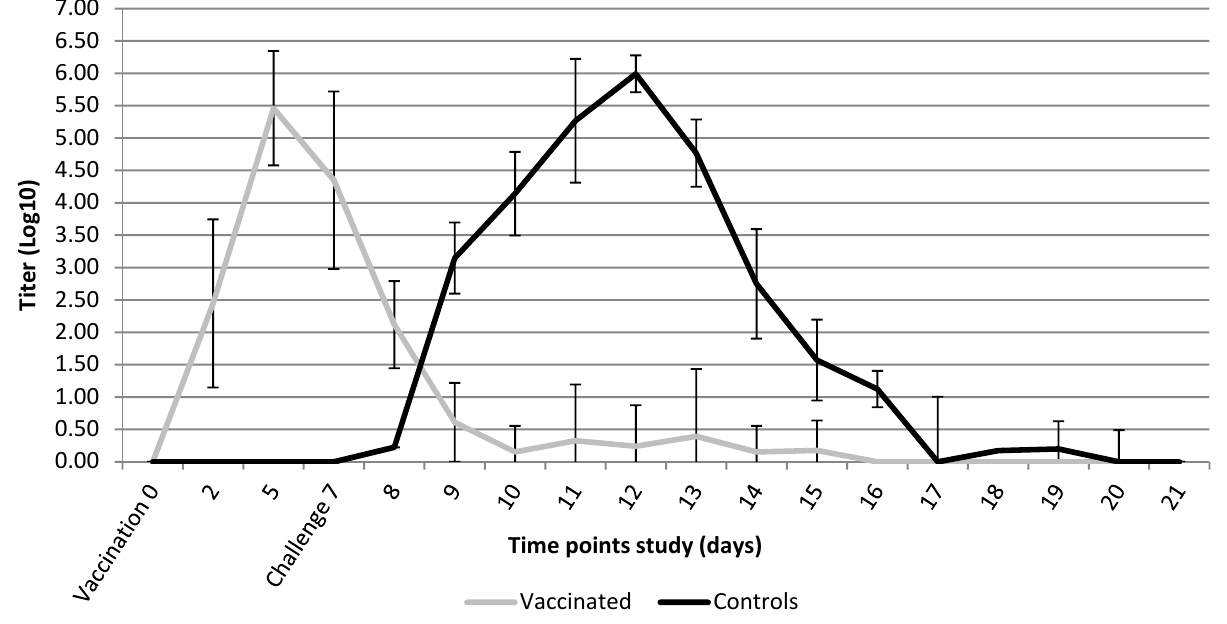
Figure 1. BPIV3 nasal shedding (mean titer log 10 TCID 50 /mL) post-vaccination and 14 days post- challenge period. Shedding in the vaccinated group before challenge moment is caused by BPIV3 vaccine strain.